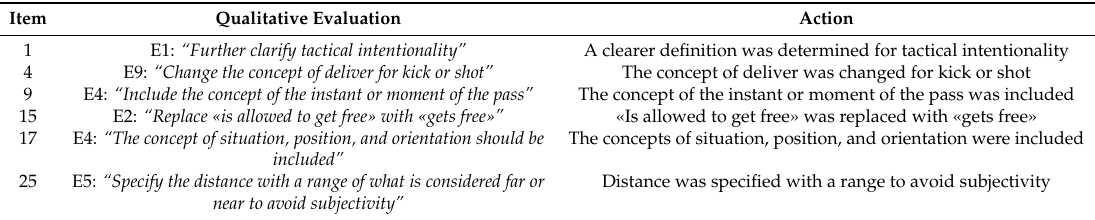
Table 7. Qualitative evaluations issued by the